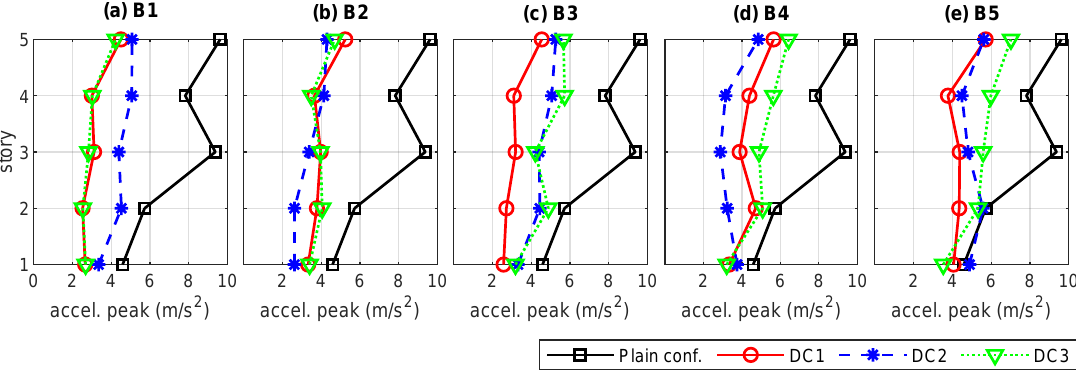
Figure 10. Maximum absolute story total-accelerations attained by the nonactuated multibuilding system (plain configuration) and the damping configurations DC1, DC2 and DC3.